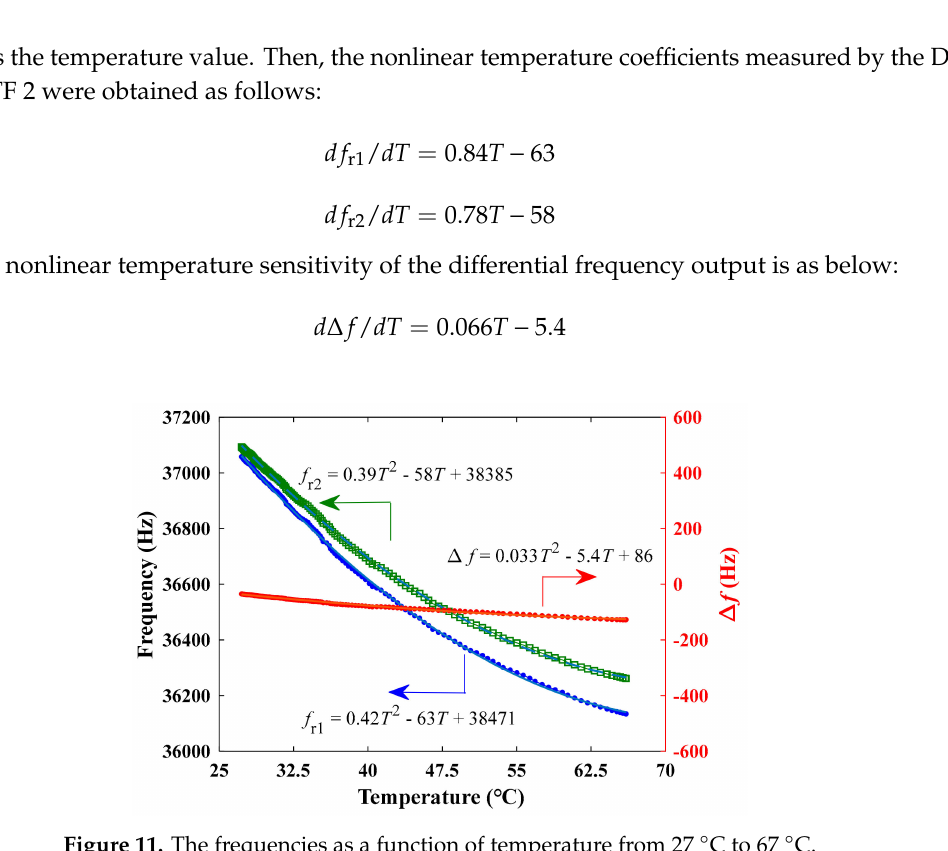
Figure 11. The frequencies as a function of temperature from 27 ◦ C to 67 ◦ C.